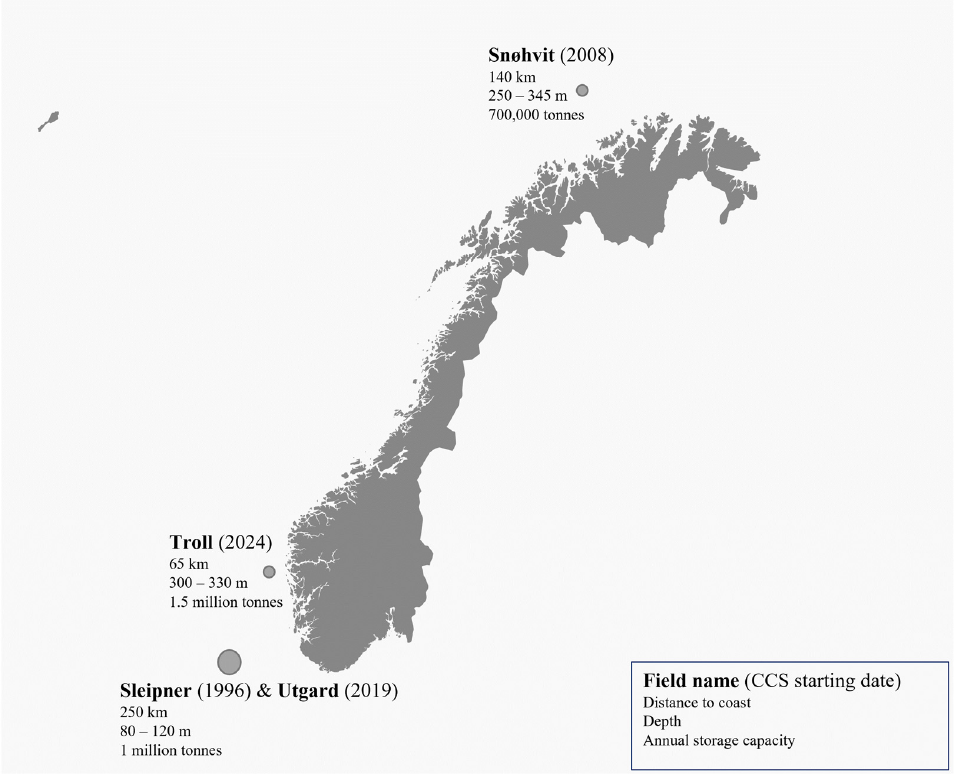
Figure 2. CCS storage sites in the Norwegian sector [8].